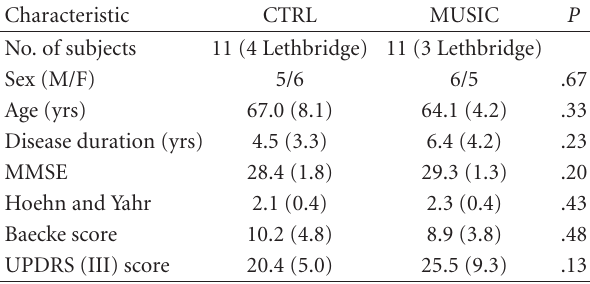
Table 1: Subject demographics and clinical characteristics at